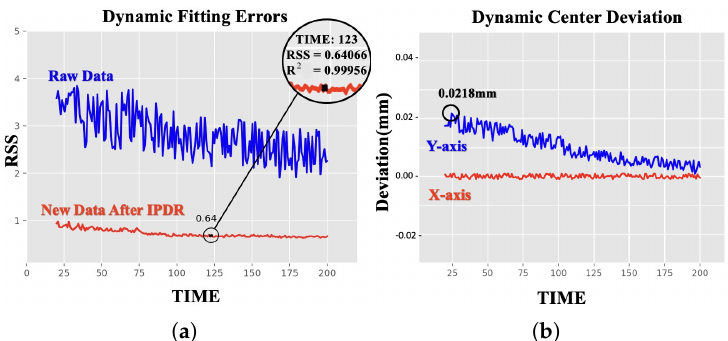
Figure 7. Fitting Error Analysis. ( a ) Dynamic fitting residual sum of squares for uni-directional data processing. ( b ) The location deviation of stress distribution center for omni-directional data